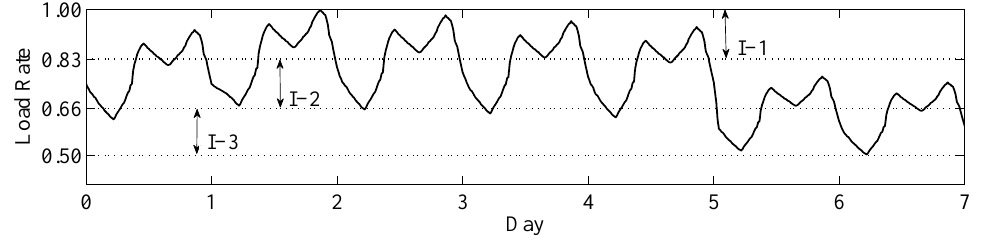
Figure 6. Weekly load profile of the area load in the 57-bus power system.